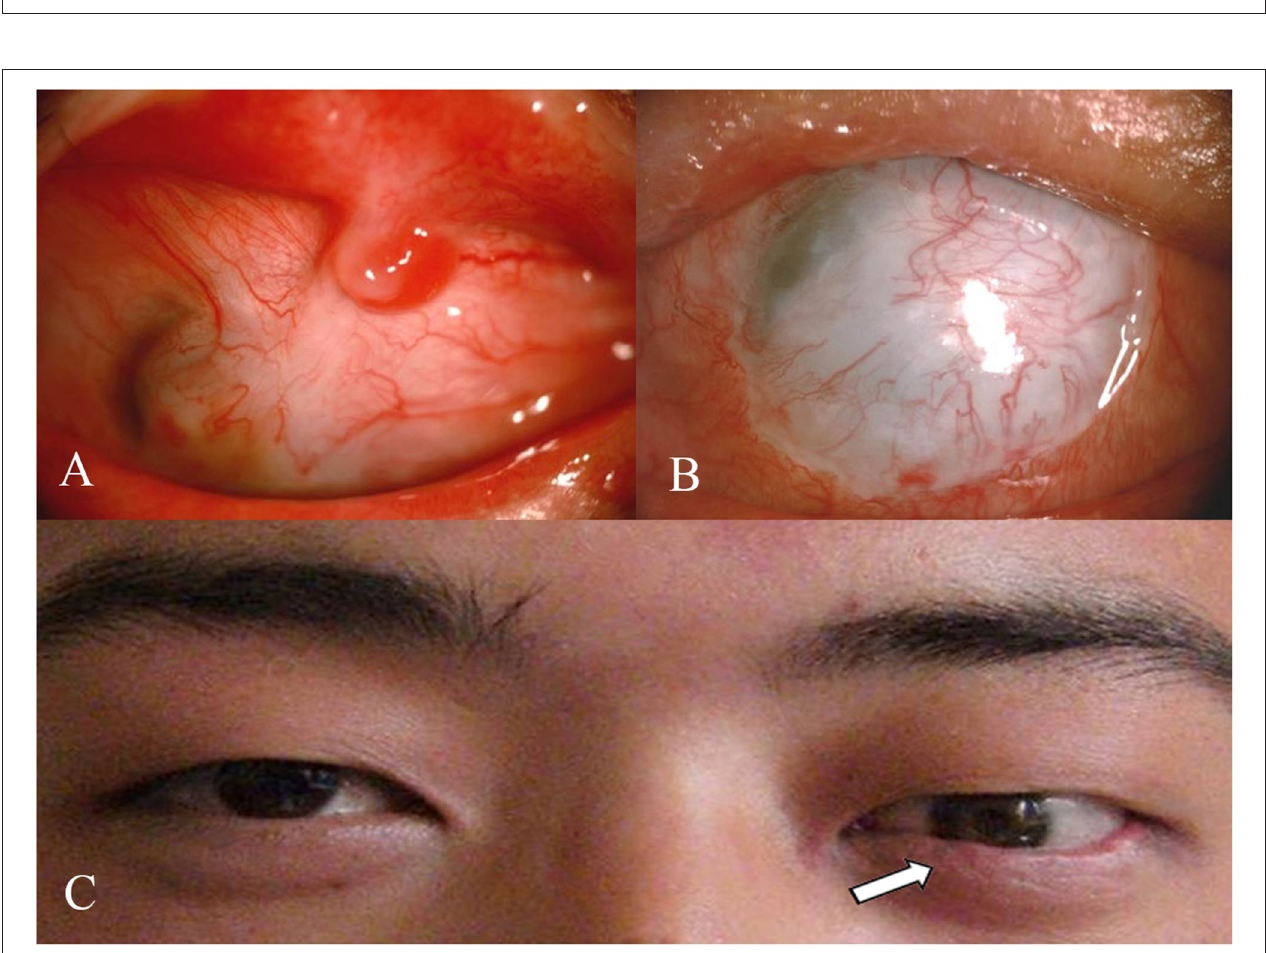
FIGURE 2 | (A) Strip-like symblepharon remained after the first CLET. (B) Symblepharon was completely released after the second allogeneic CLET. (C) A suitable prosthesis was implanted in the eye that has lost visual function, and the appearance was obviously improved.